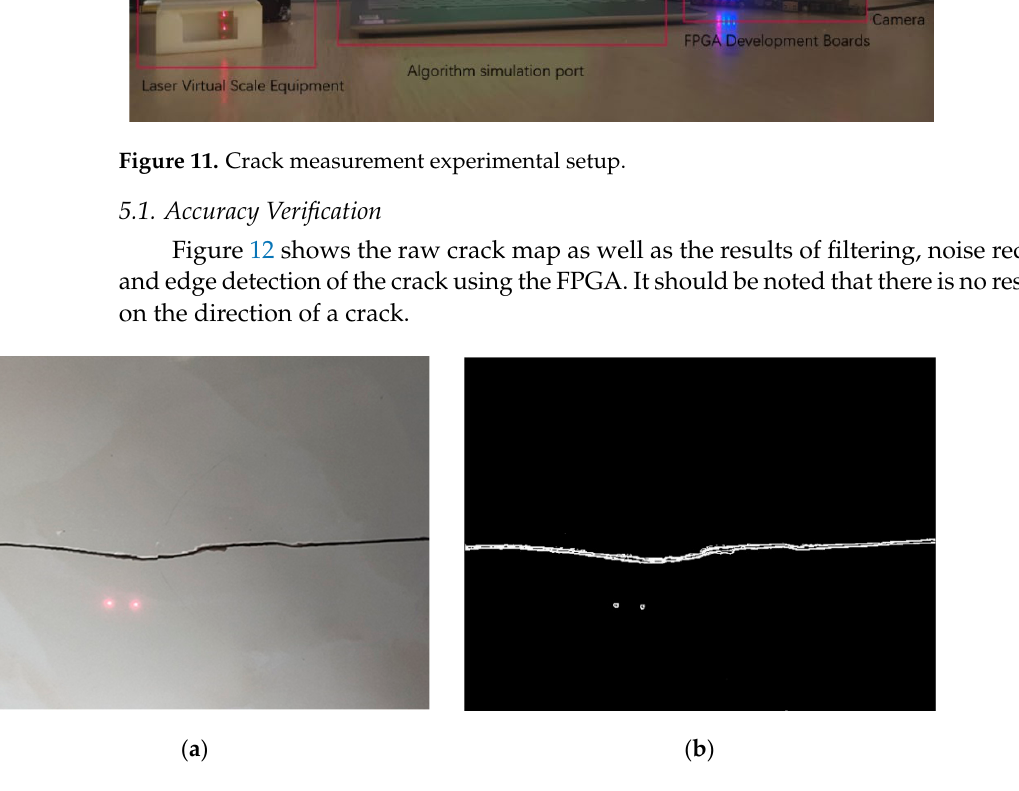
Figure 12. Crack width measurement experiment. ( a ) Original picture of the crack experiment. ( b ) Crack map after image processing.